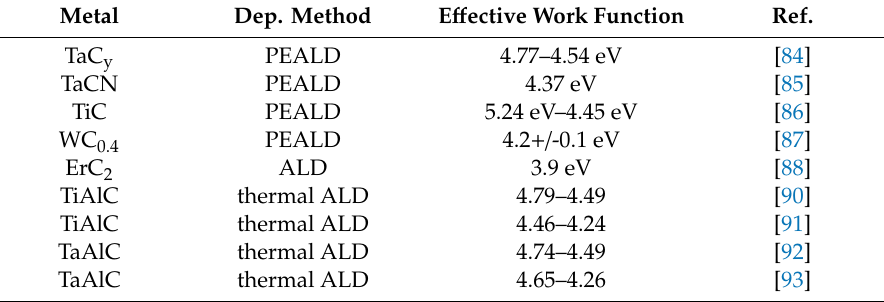
Table 2. The e ff ective work function of di ff erent metals grown by ALD for NMOSFET.